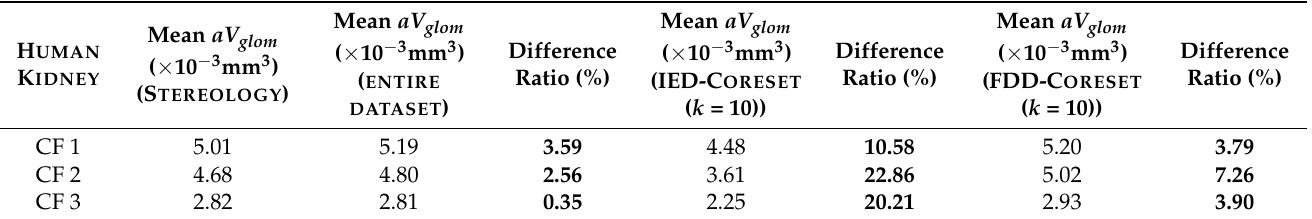
Table 6. Human kidney glomerular segmentation results (mean aV glom ) using BlobGAN trained on entire dataset (1000 Random Samples), IED-Coreset ( k = 10) and proposed FDD-Coreset ( k = 10) comparing with stereology.